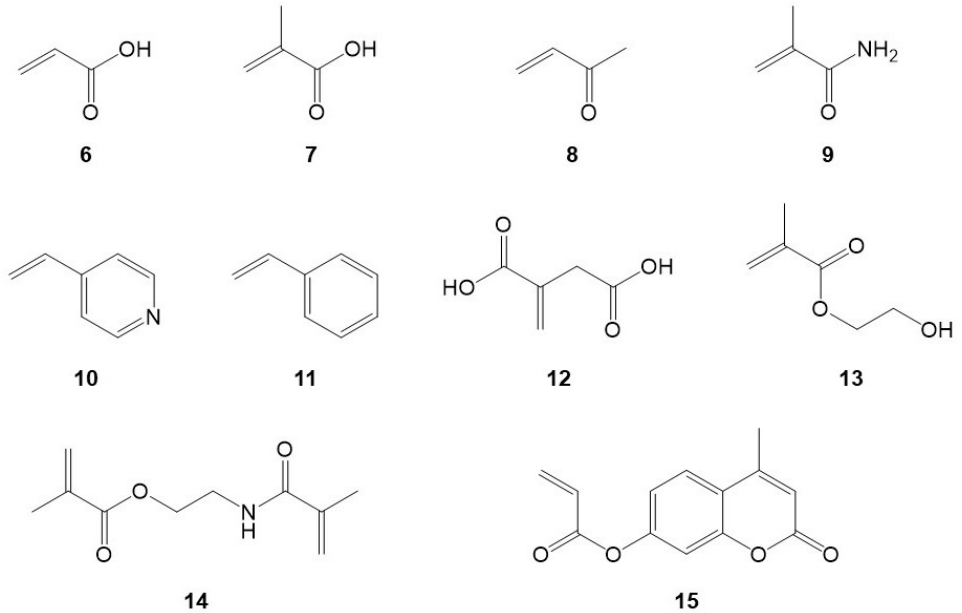
Figure 2. Chemical structures of functional monomers examined in this study: acrylic acid ( 6 ), methacrylic acid ( 7 ), acrylamide ( 8 ), methacrylamide ( 9 ), 4-vinylpyridine ( 10 ), styrene ( 11 ), itaconic acid ( 12 ), 2-hydroxyethyl methacrylate ( 13 ), N,O -bismethacroyloyl ethanolamine (NOBE) ( 14 ) and 7-hydroxy-4-methylcoumarin acrylate ( 15 ).